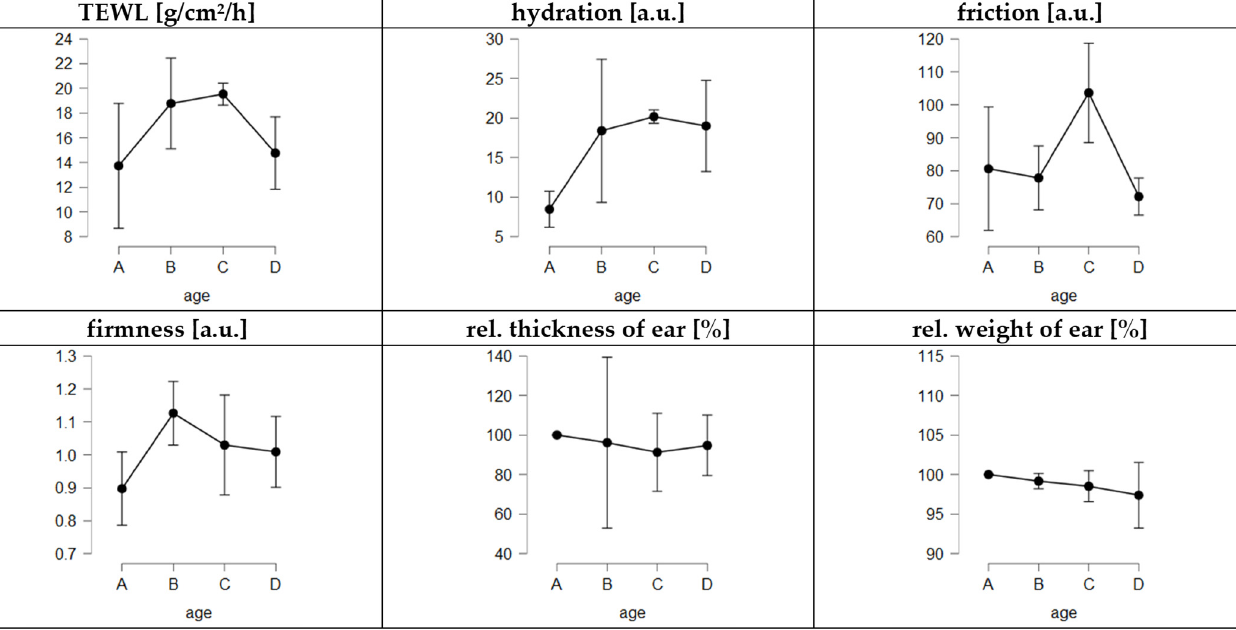
Figure 7. Influence of storage time of ears on skin parameters. A = fresh ears (4–6 h after slaughter), B = ears 10–12 h after slaughter, C = ears 24–36 h after slaughter, D = ears 48–60 h after slaughter.